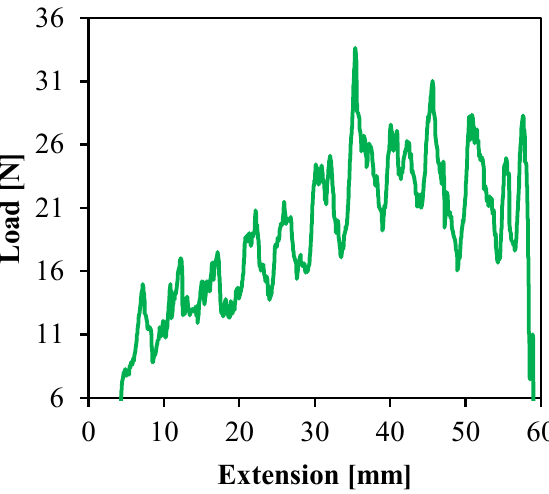
Figure 9. Peel load curve of the PP SPC as a function of extension.